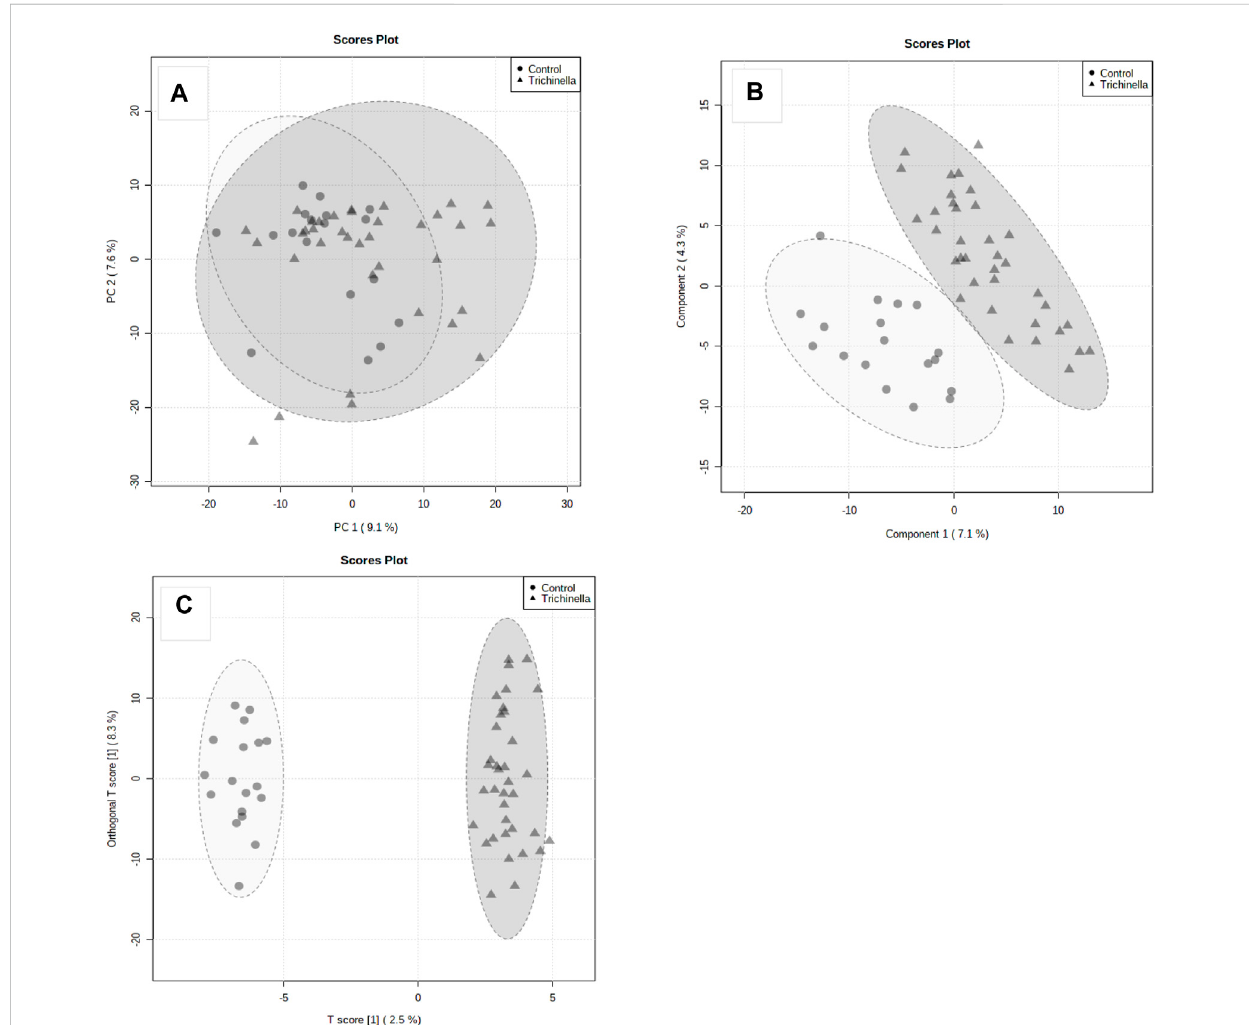
FIGURE 3 Principal Component Analysis (PCA) (A) , PLS Discriminant Analysis (PLS-DA) (B) , and (C) Orthogonal PLS-DA score plots. The score plots, the abscissa PC1, and the ordinate PC2 represent the scores of the principal components ranking the fi rst and the second, respectively, and different shapes of the scattered points represent the different groups of the samples. The explained variances are shown in brackets. The Orthogonal PLS-DA score plot (C) of Tz-infected rats (Grey triangles) and the control rats (Grey